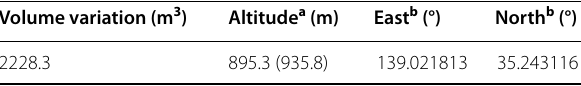
Table 4 Estimated parameters of point pressure source beneath the local swelling in